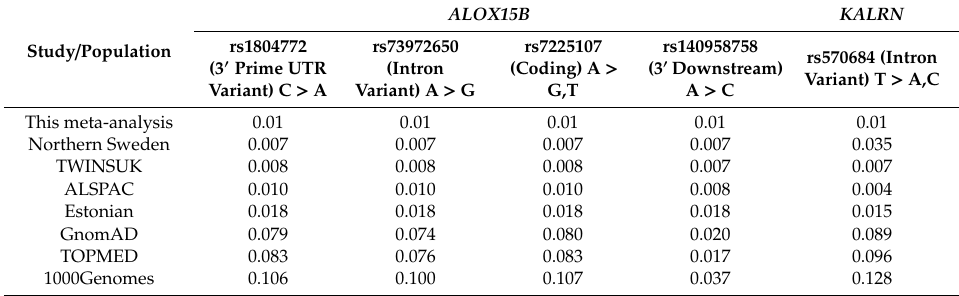
Figure 3. Locus zoom plot of ALOX15B top SNP rs1804772. SNPs located either side of rs1804772 (purple dot, labelled), at a distance of 300 kilobases, are shown. r2 refers to linkage disequilibrium with rs1804772, where values closer to 1.0 indicate SNPs in strong linkage disequilibrium with rs1804772. The MAF of these SNPs in comparison to reference populations is presented in Table 3. Table 3. Minor allele frequencies for ALOX15B and KALRN SNPs in reference